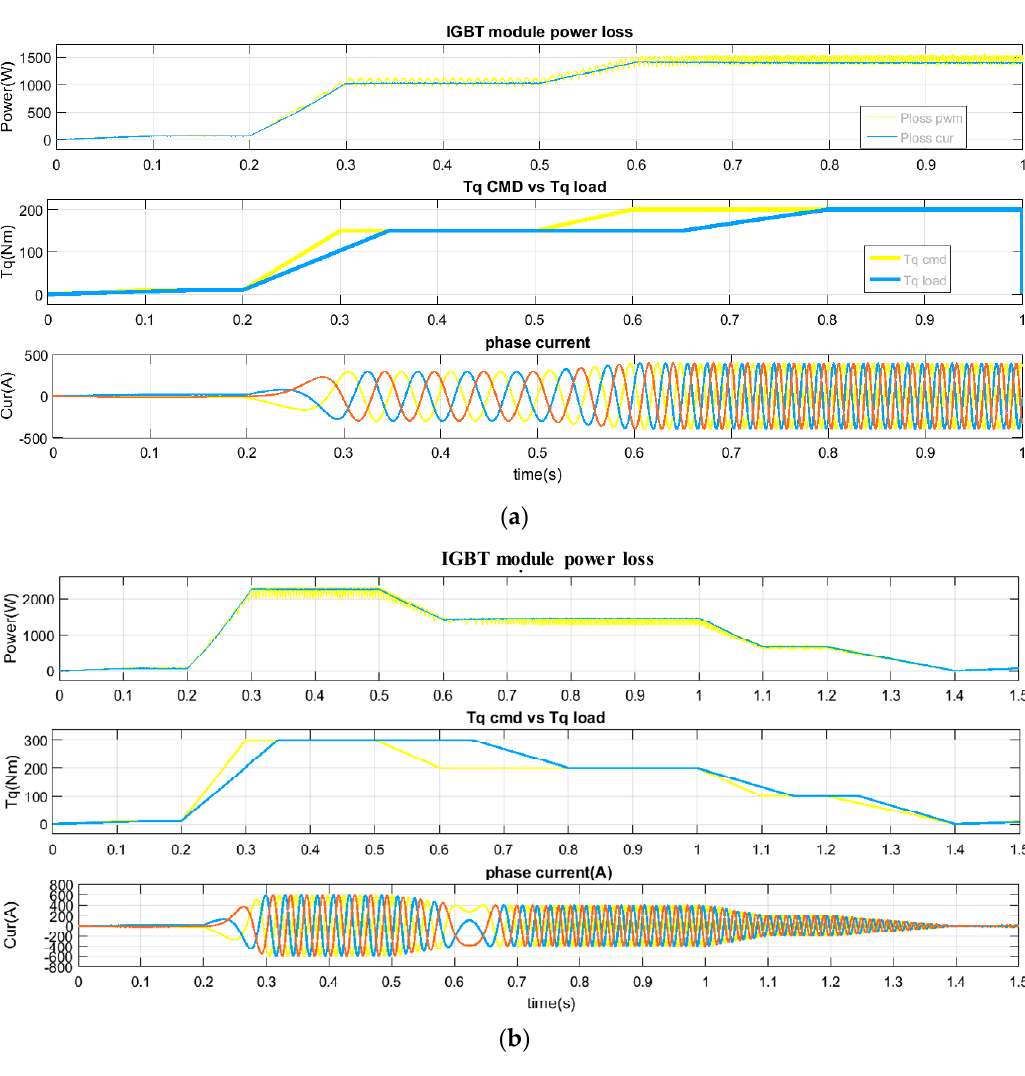
Figure 13. Comparison of two losses models. ( a ) The torque rise. ( b ) The torque drop.